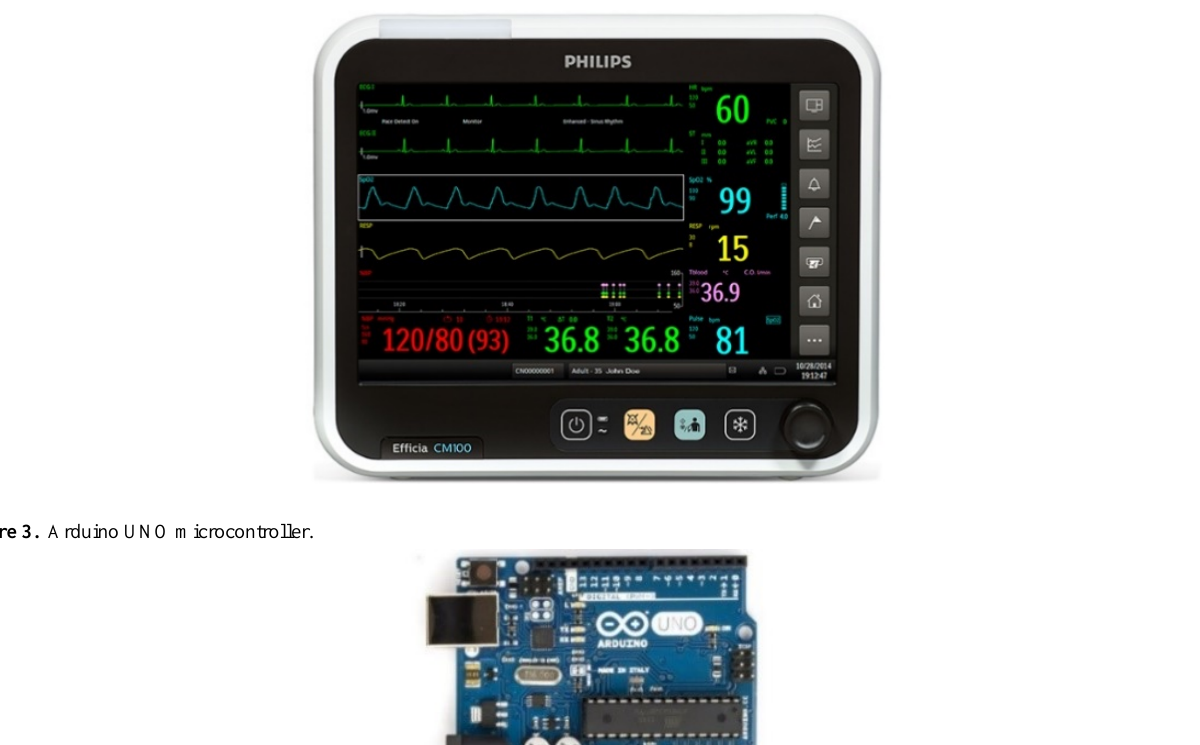
Figure 2. The Philips Efficia CM100 monitor.